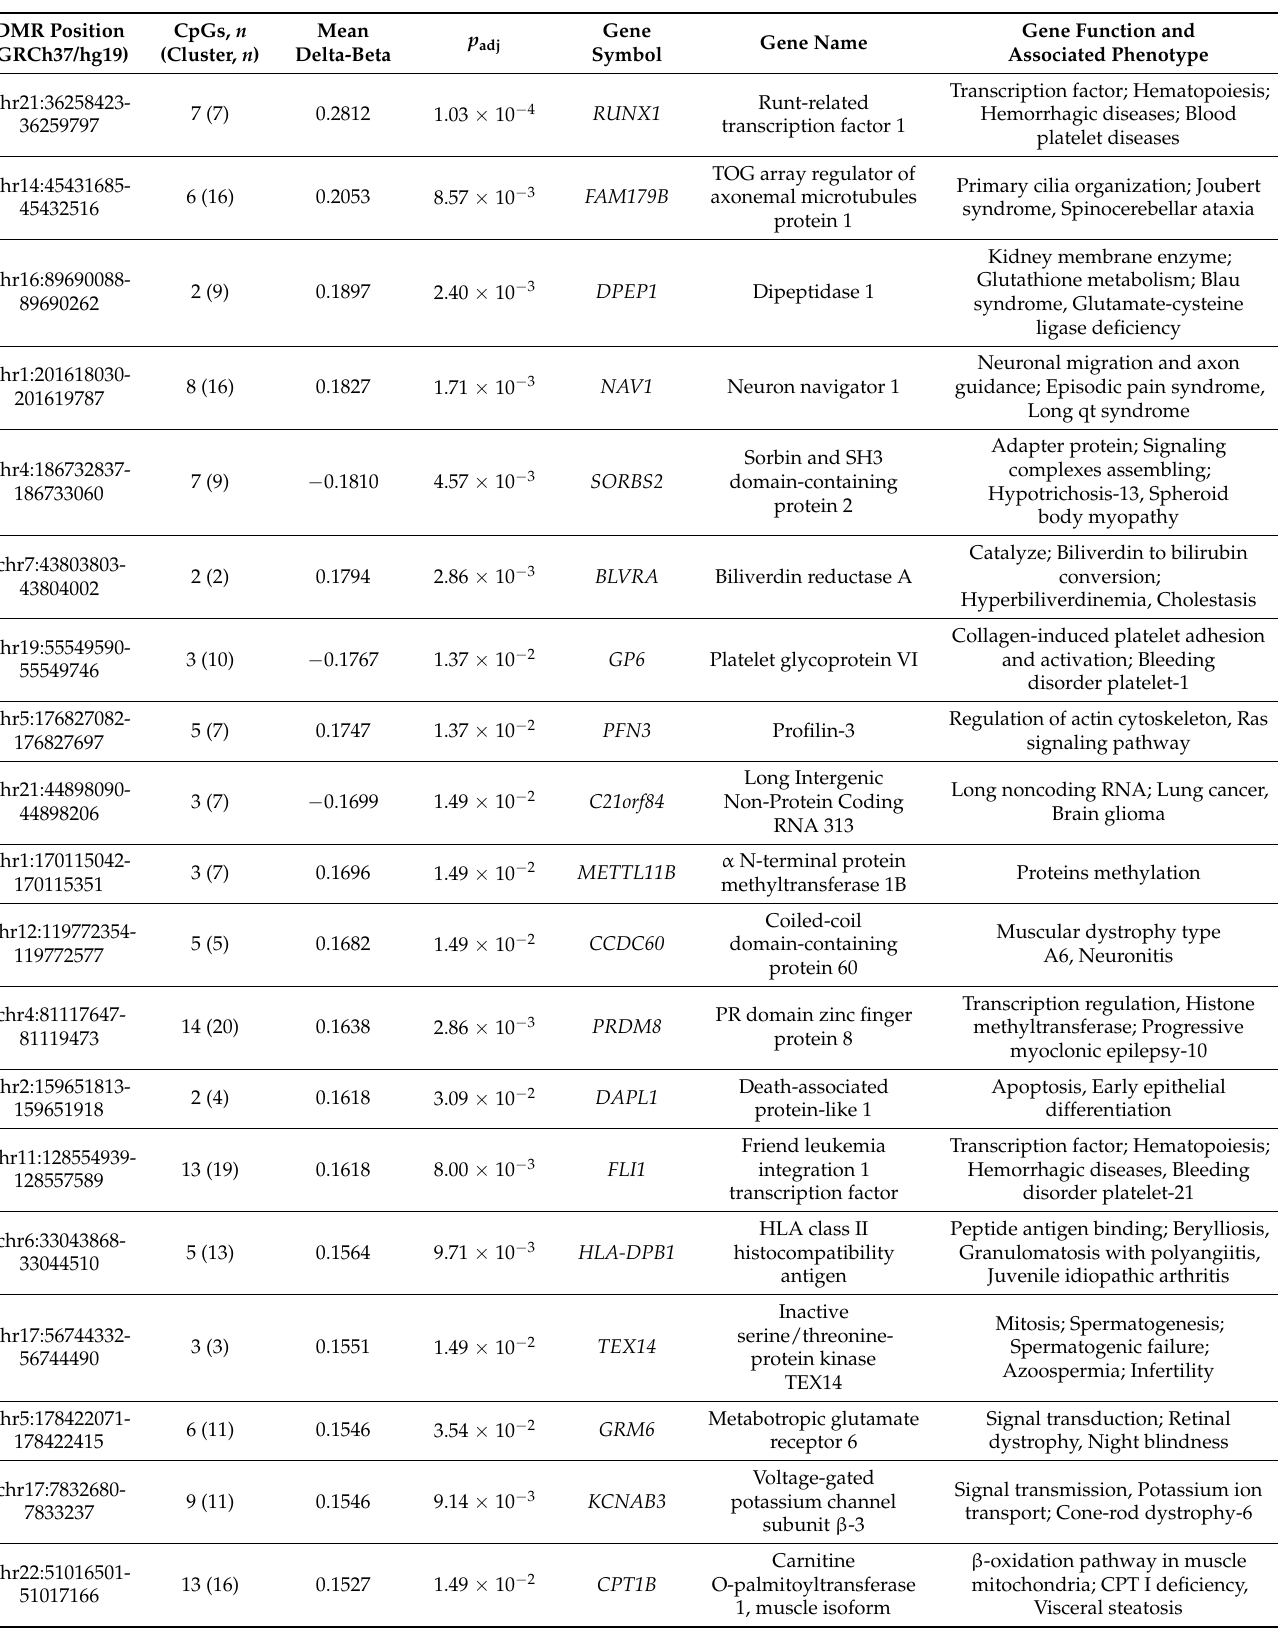
Table 3. Top differentially methylated regions (DMRs) in the blood cells of toddlers with Down syndrome compared to typically developing peers; the DMRs are ordered by the mean methylation level difference (mean delta-beta value) in DS. DMR Position